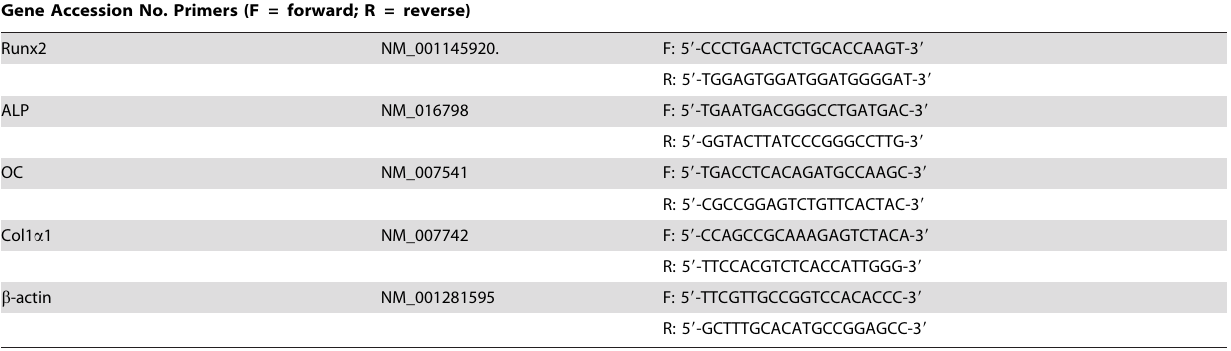
Table 1. Targeted gene sequences of the primers used for real-time PCR.